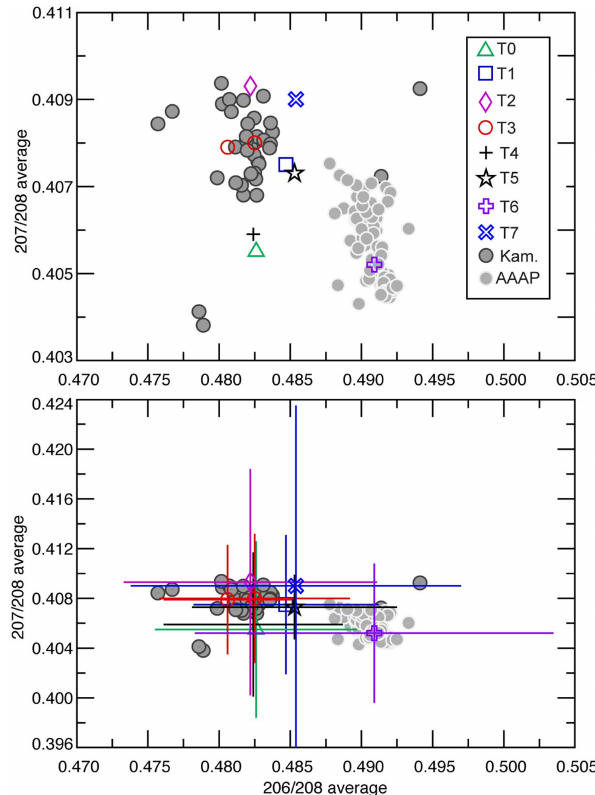
Figure 7. Lead isotope composition of El’gygytgyn tephra lay- ers (T0–T7). Top: average 206 Pb/ 208 Pb vs. 207 Pb/ 208 Pb for sam- ples from El’gygytgyn core. Bottom: average 206 Pb/ 208 Pb vs. 207 Pb/ 208 Pb for samples from El’gygytgyn core including 2 σ er- ror bars. Data are plotted with previously published Pb isotope com- positions of volcanic rocks from the AAAP (Aleutian Arc–Alaska Peninsula) and Kamchatka (Myers and Marsh, 1987; Kepezhinskas et al., 1997; Bindeman et al., 2010; George et al., 2004; Jicha et al.,